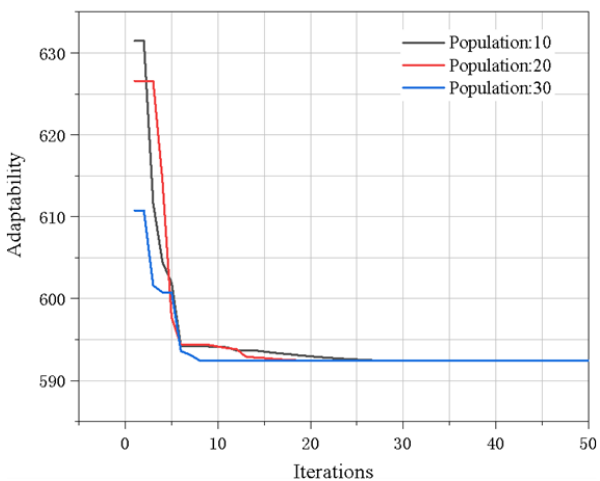
Figure 10. Iterative process of